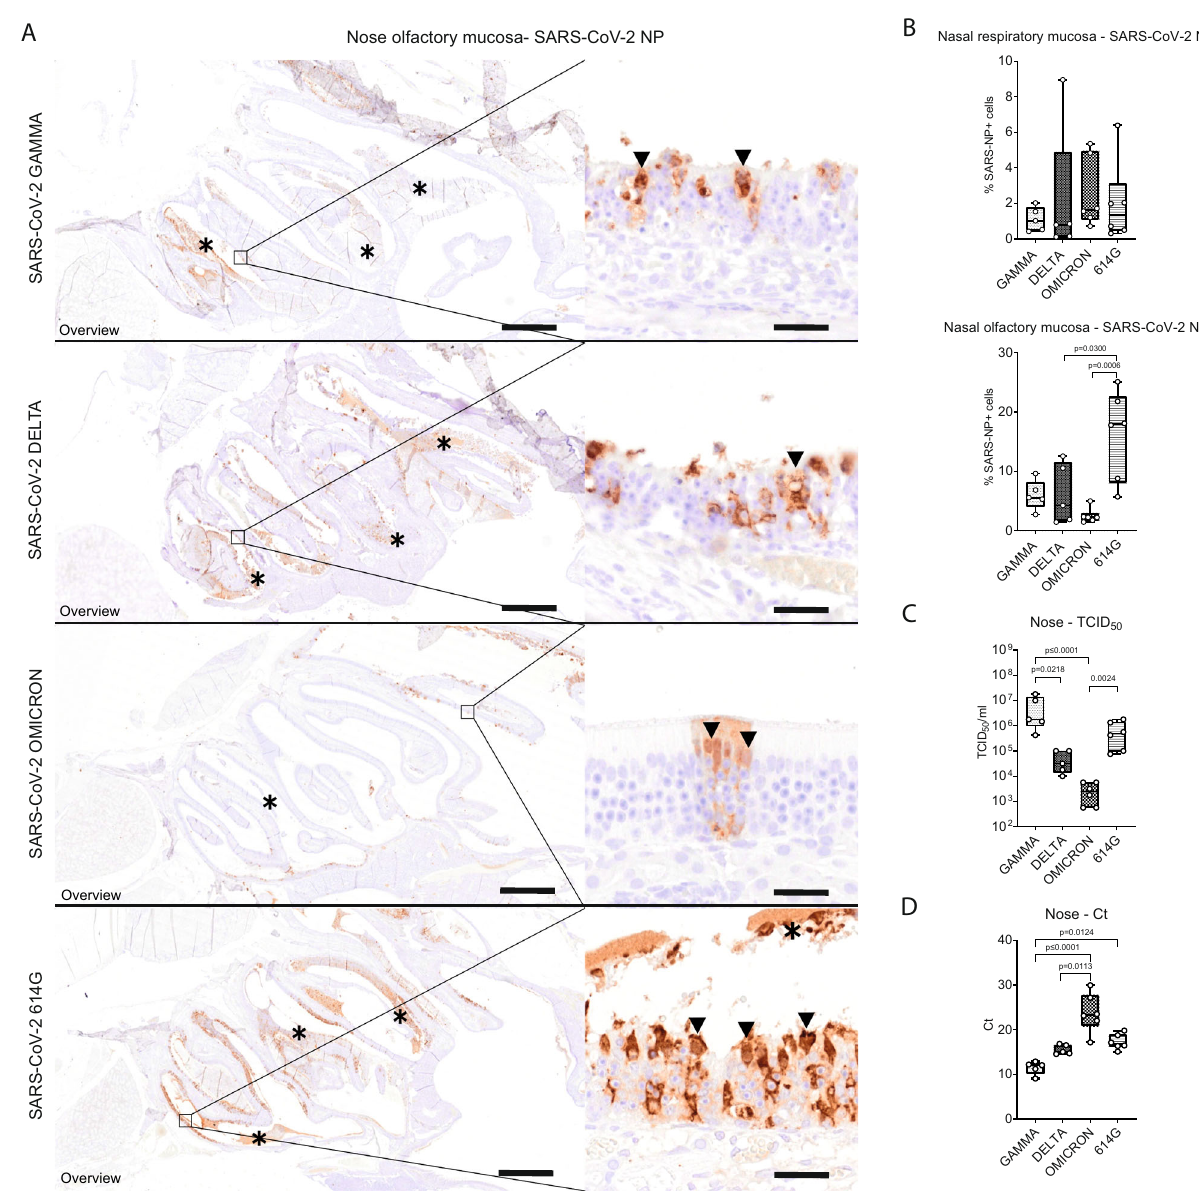
Fig. 3 VOC Omicron infected hamsters showed decreased viral antigen, RNA and infectious viral titers in the nasal turbinates compared to other SARS-CoV-2 strains. A Representative images showing SARS-CoV-2 nucleoprotein (NP) immunolabeling in the nasal turbinates of hamsters infected with VOCs Gamma, Delta, Omicron or 614 G strain. The images depict an overview of the caudal nasal turbinates (left panel) and high magni fi cation of the olfactory mucosa (right panel). Viral antigen (brown signal) was mainly detected in epithelial cells within the olfactory mucosa and within intraluminal exudates (asterisks). Based on the cell morphology, characterized by apically located nuclei and abundant apical cytoplasm, most of these cells were sustentacular cells (arrowheads). The number of positive cells was highest in hamsters infected with 614 G, followed by hamsters infected with VOCs Gamma or Delta. In hamsters infected with VOC Omicron, only rare foci with a few positive cells were observed. Scale bars: 1 mm (overview) and 20 µ m (high magni fi cation). B Quanti fi cation of SARS-CoV-2 NP antigen in the respiratory and olfactory mucosa. VOC Omicron infected hamsters displayed a signi fi cantly lower number of immunolabeled cells in the olfactory mucosa compared to hamsters infected with 614G. C Quanti fi cation of infectious SARS- CoV-2 titers in the nasal turbinates. Titers were signi fi cantly lower in VOC Omicron infected hamsters compared to 614 G and VOC Gamma infected hamsters. D Quanti fi cation of SARS-CoV-2 RNA by qRT-PCR (Ct values). VOC Omicron infected hamsters show signi fi cantly higher Ct values, corresponding to low RNA content, compared to VOCs Gamma and Delta infected hamsters. B – D Data are shown as box and whisker plots. The bounds of the box plot indicate the 25th and 75th percentiles, the bar indicates medians, and the whiskers indicate minima and maxima. Data were tested by two- tailed Mann – Whitney-U tests followed by Benjamini – Hochberg correction. A p -value of ≤ 0.05 was chosen as the cut-off for statistical signi fi cance. N = 5 animals/group for VOCs Gamma and Delta and 6 animals/group for VOC Omicron and 614 G. For quanti fi cations, one entire longitudinal section of the nasal turbinates was evaluated per animal. Source data are provided as a Source Data fi le. Ct = cycle threshold; TCID 50 = tissue culture infection dose